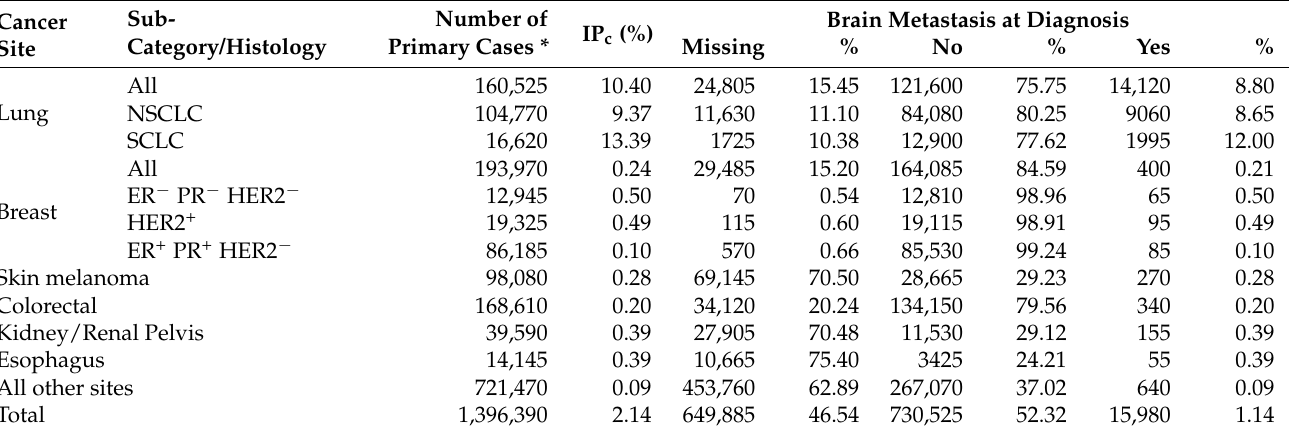
Table 1. Frequency of concurrent brain metastases and crude incidence proportions (IPc) in Canada by selected cancer sites (2010–2017).